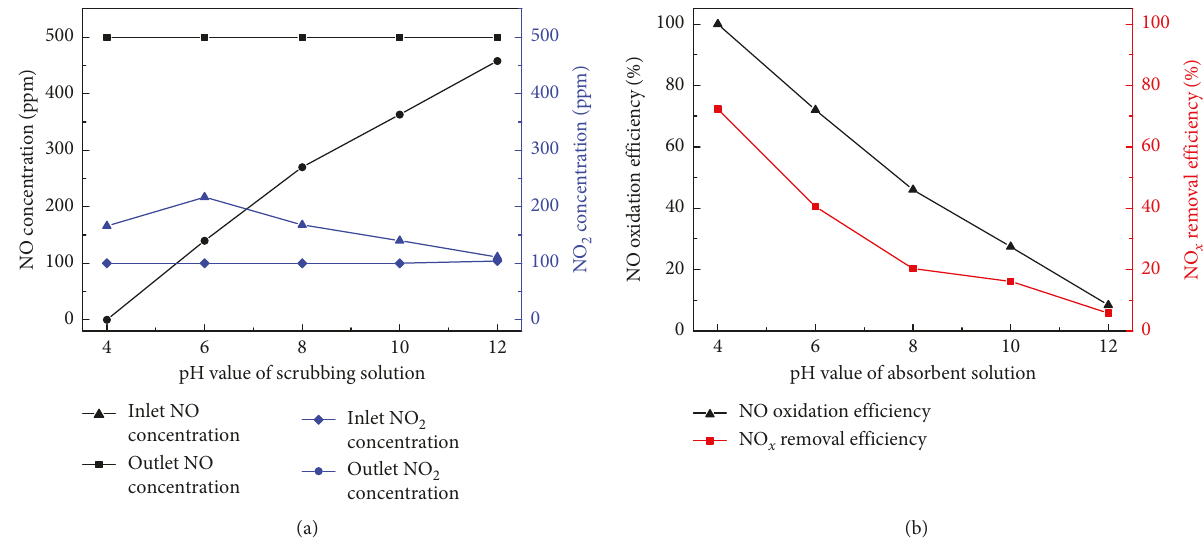
Figure 3: Changes of NO x concentrations at inlet and outlet ports of the RPB reactor (a) and NO x removal efficiencies (b) with solution pH.